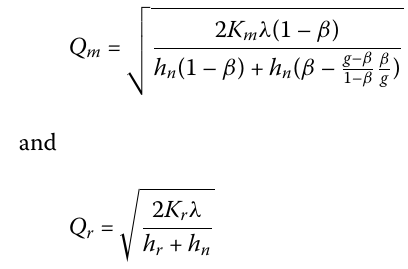
The formulas for the optimal batch size for manufacturing, Q m , and for recovery, Q r